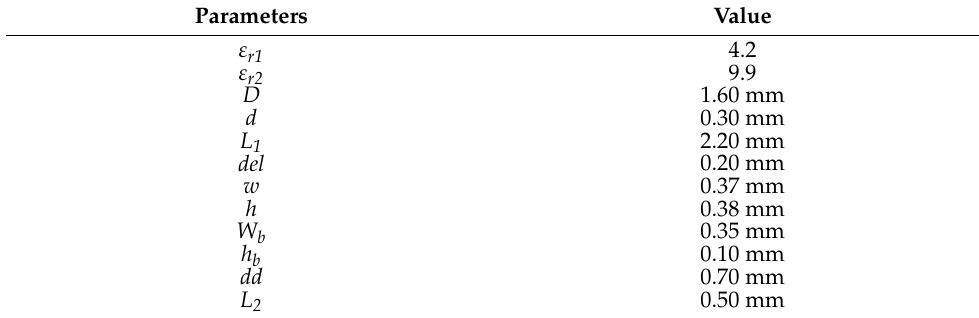
Table 4. Parameters of the novel horizontal interconnection structure.